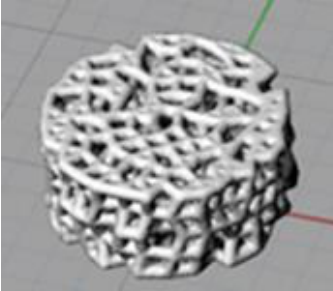
Figure 3. Structure obtained after applying the marching cubes algorithm to a disk shape.